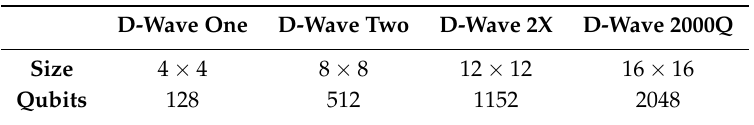
Table 1. Quantitative characteristics (qubits and connectivity) of the Chimera topology of previous D-Wave generations (from